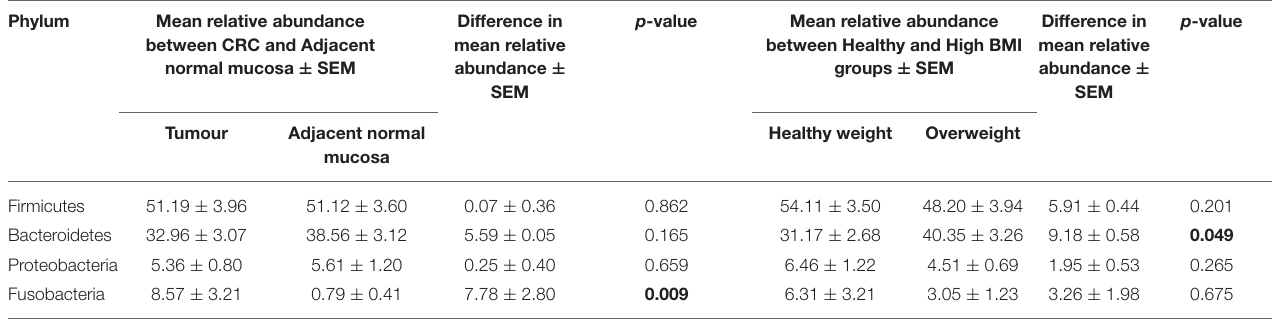
TABLE 3 | Mean difference in the relative abundance of the 4 major phyla Firmicutes, Bacteroidetes, Proteobacteria, and Fusobacteria from the CRC sample cohort between polyp and paired normal samples, and between normal weight and overweight patient samples. p -value Mean relative abundance p -value Phylum Mean relative abundance Difference in Difference in between CRC and Adjacent mean relative between Healthy and High BMI mean relative normal mucosa ± SEM abundance ± groups ± SEM abundance ± SEM SEM Tumour Adjacent normal Healthy weight mucosa